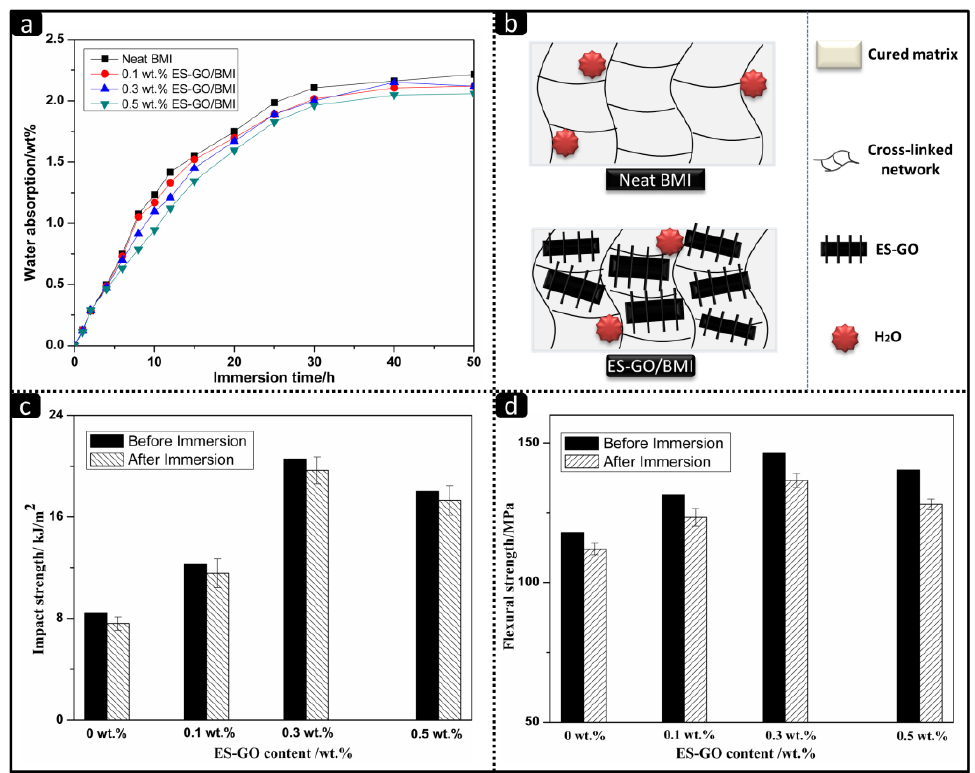
Figure 7. ( a ) Water absorption curves of cured resins with different content of ES-GO under boiling water; ( b ) Mechanism of water resistance; ( c ) Impact strength and ( d ) flexural strength of resin systems before and after immersing in boiling water.